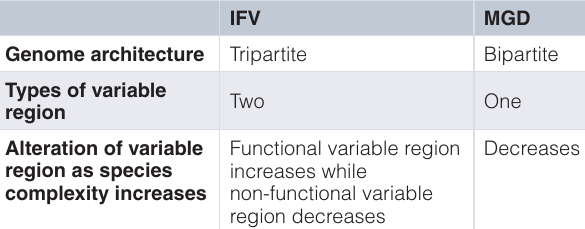
Table 1. Comparison of IFV hypothesis and MGD